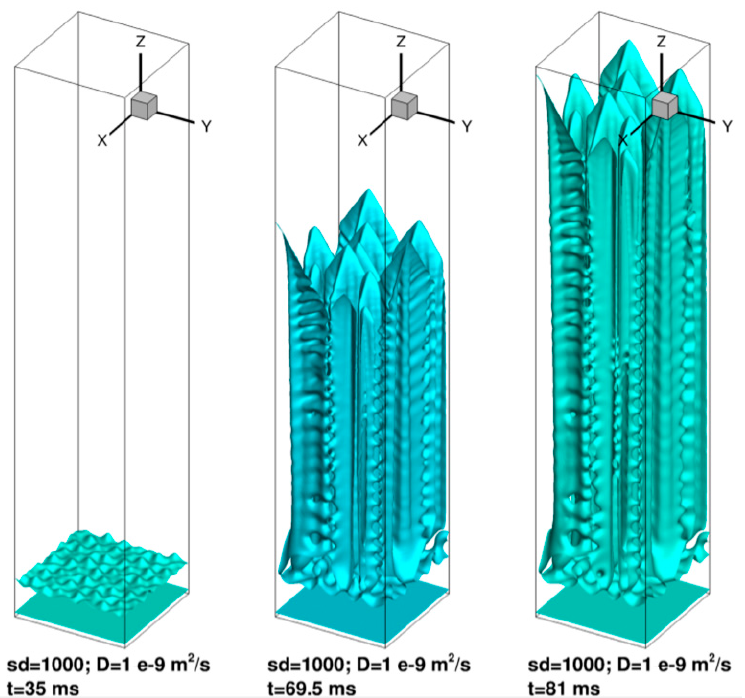
Figure 17. Simulation of non-steady state solidification in 3D with an imposed temperature gradient in the liquid of 4.6 × 10 6 K/m, and an initial interface temperature of 1630 K.